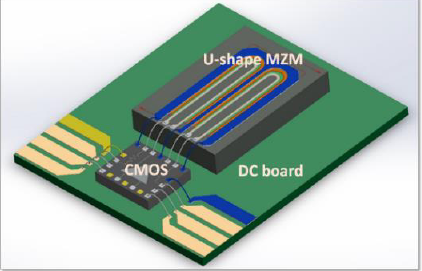
Fig. 3. Schematic of CMOS driver – U shape modulator integration with wire bonds.